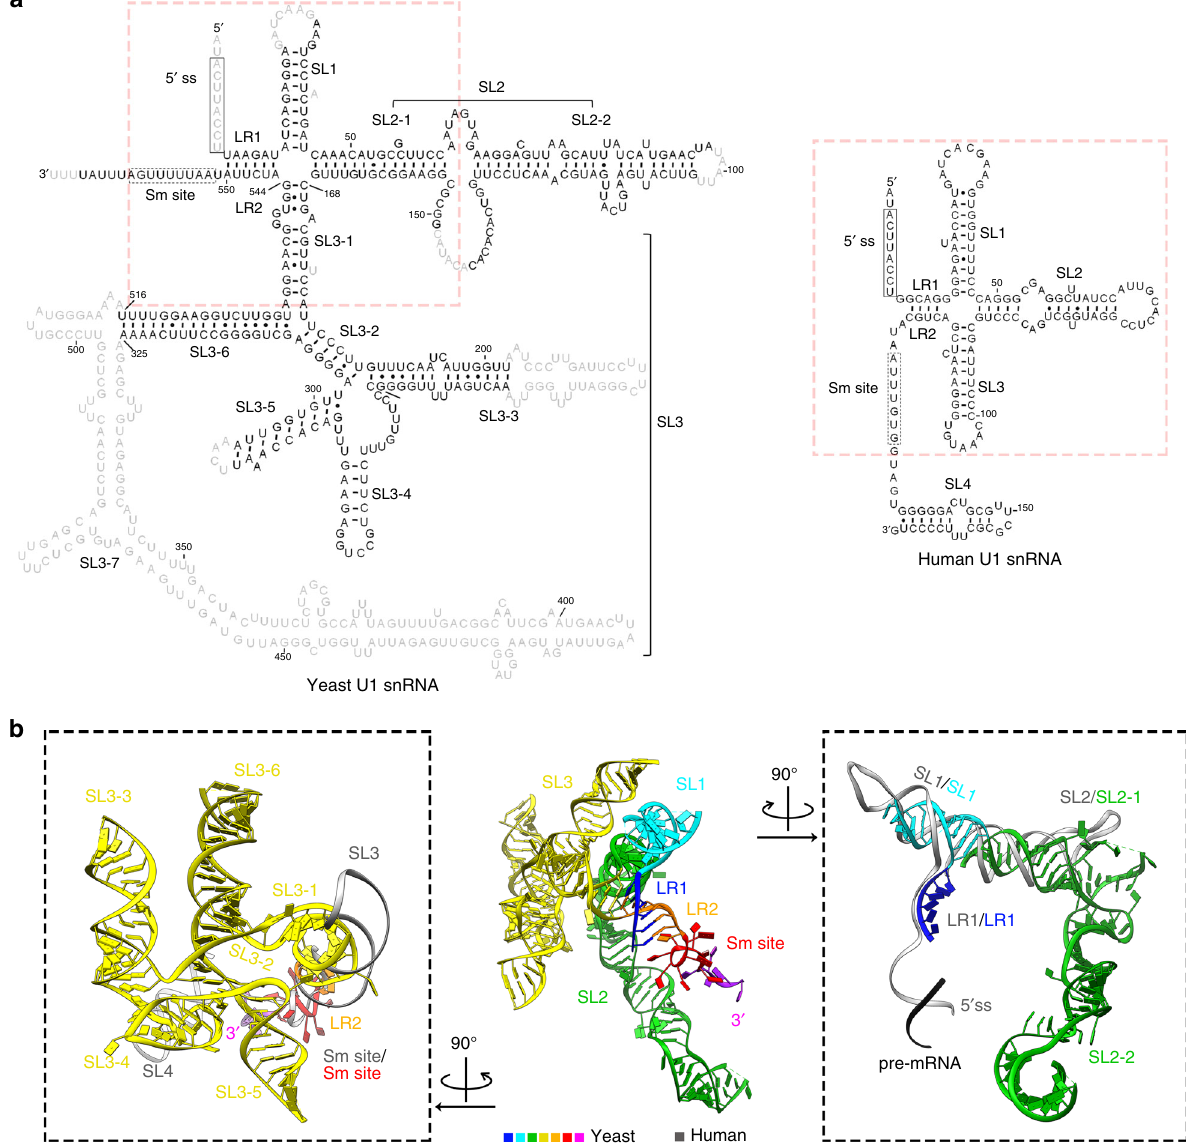
Fig. 2 The similarities and differences between human and yeast U1 snRNA. a Secondary structures of human and yeast U1 snRNA based on the three dimensional structures. Light gray nucleotides are not built in the structure. Red dashed box represents the core components common between the two RNAs. b Structure of the entire yeast U1 snRNA (LR1, SL1, SL2, SL3, LR2, Sm site, and 3 ʹ -tail in blue, cyan, green, yellow, orange, red, and purple, respectively) in an orientation similar to the right panel of Fig. 1b. Also shown are structural comparisons of isolated areas of human (grey, PDB ID 3PGW) and yeast U1 snRNA including the SL3 to the 3 ʹ -tail (left) and 5 ʹ -ss-binding region to SL2